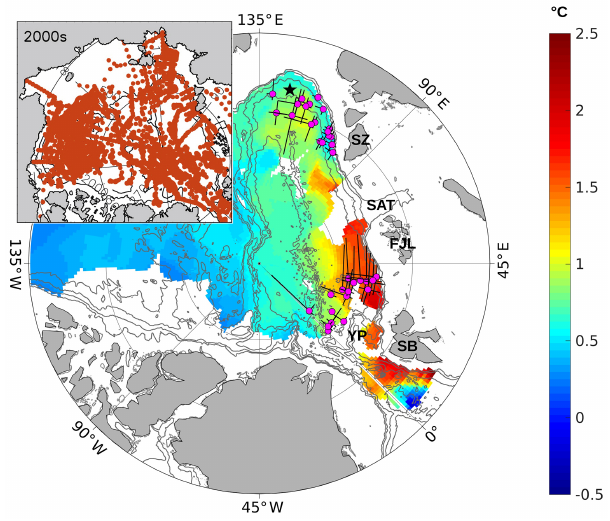
Figure 8. Results of the identification of eddy origins using the M1f mooring record (2007–2011). Pink circles show the locations of cli- matological profiles with maximal temperature and salinity simi- larity with profiles observed inside the eddy cores. The black star shows the M1f mooring position. Climatological temperature ( ◦ C, color bar) for the 2000s averaged within the 200–800m layer is shown by color (white spots indicate no data). Black crosses with uneven crossbars at the center of each origin indicate estimated er- rors of eddy origin position (longer crossbars indicate larger errors in the eddy origin position). Note that for some eddies, confidence intervals are small and not distinguishable at this scale. Gray con- tours show isobaths. SB, YP, FJL, SAT, and SZ denote Spitsbergen, Yermak Plateau, Franz Josef Land, St. Anna Trough, and Severnaya Zemlya, respectively. Data coverage of oceanographic profiles used in the 2000s climatology is shown in the insert.